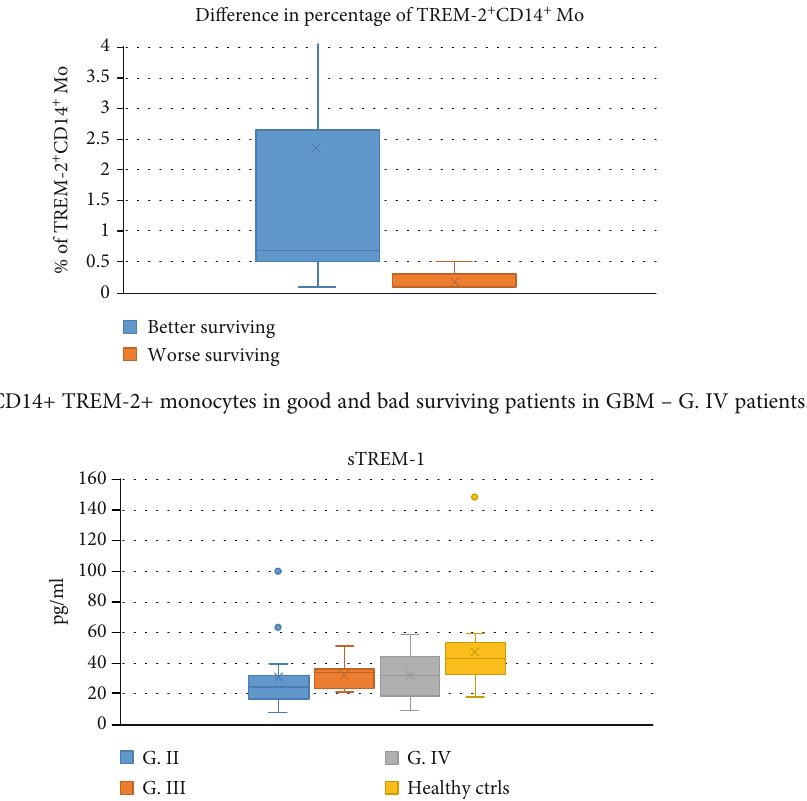
Figure 5: The serum levels of sTREM-1 in glioma patients and healthy controls. G: grade; ctrls: controls.